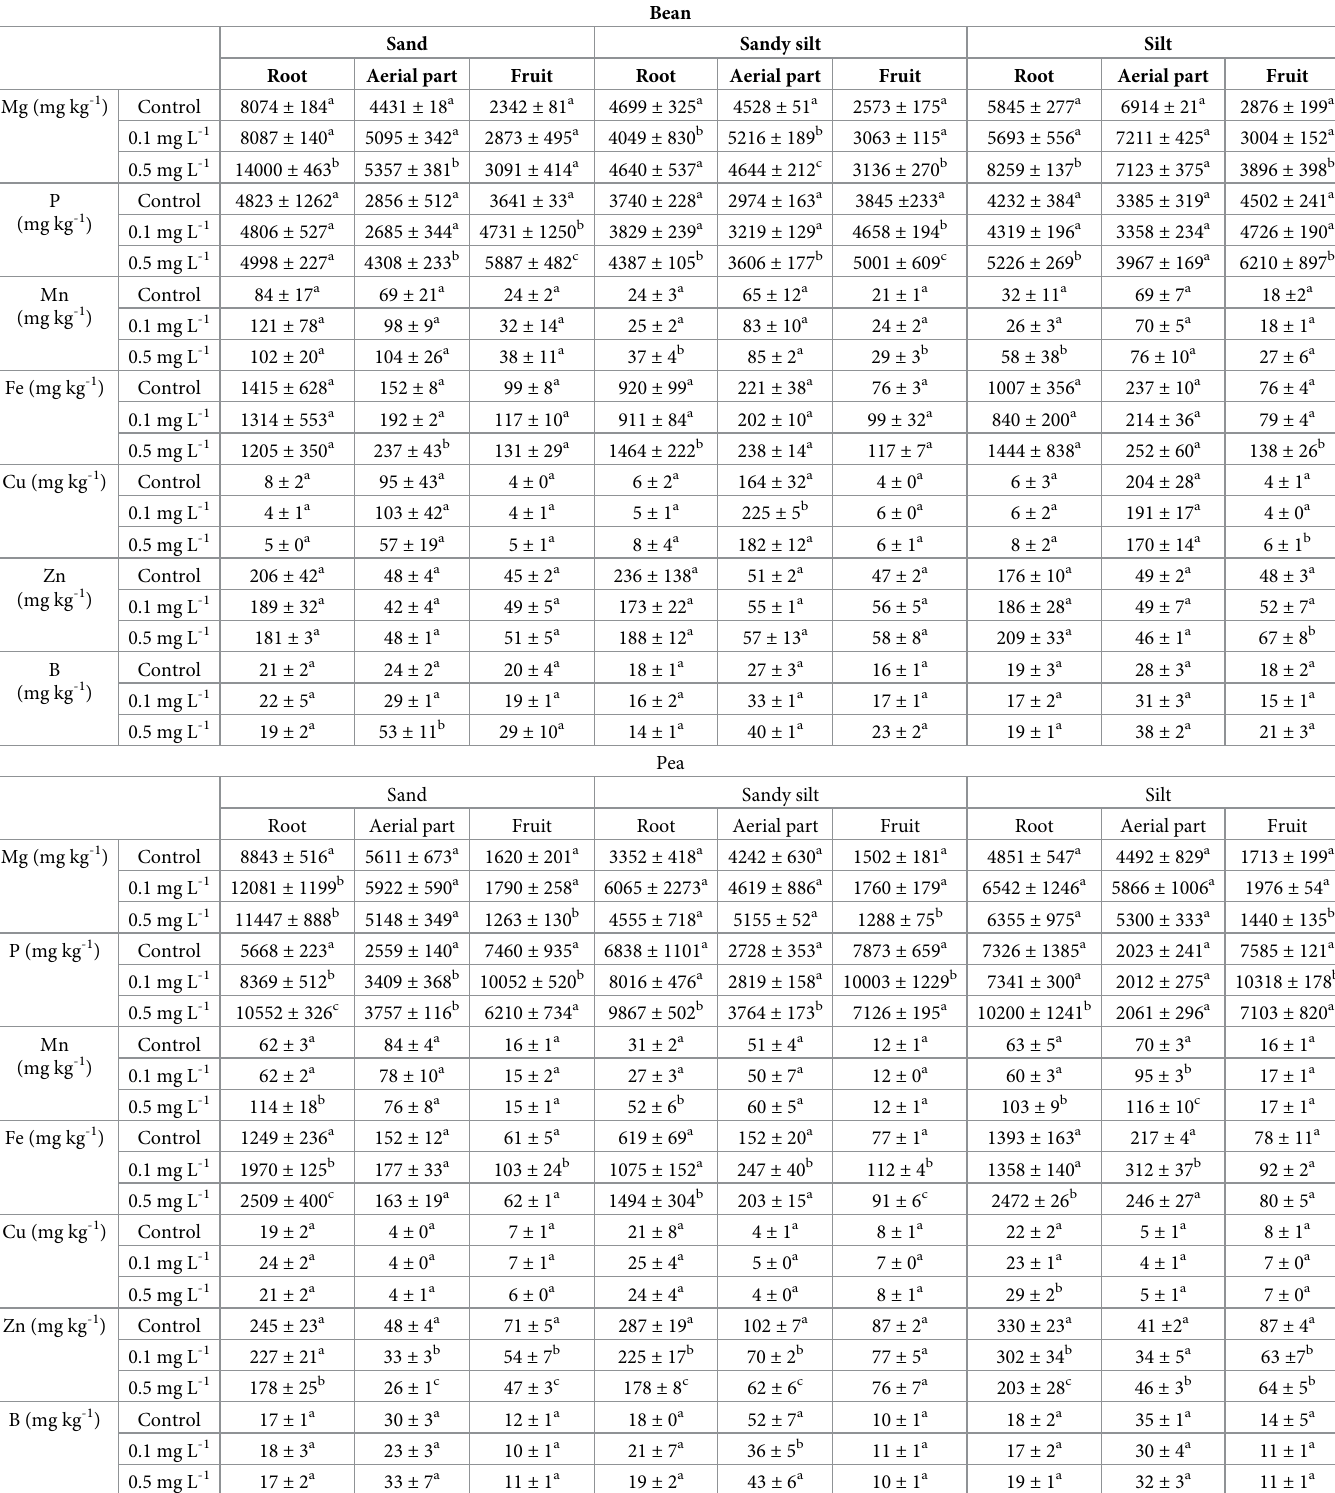
Table 7. Average macro-and micronutrient concentrations of bean and pea plant parts cultivated in three different soils and irrigated with water containing iodine. Data show the means of three replicates (RSD%) and the different letters show statistically significant differences between treatments ( p < 0.05; linear regression and Tukey’s